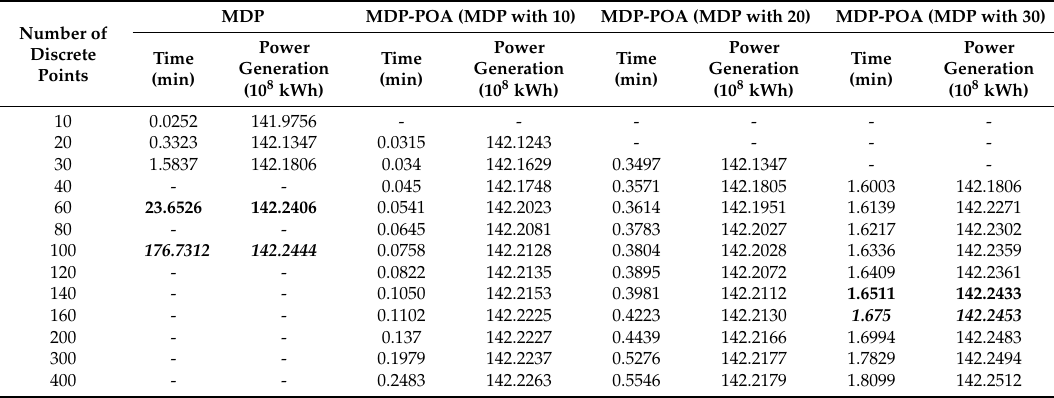
Table 5. Detailed calculation results of MDP and MDP-POA in the wet year.